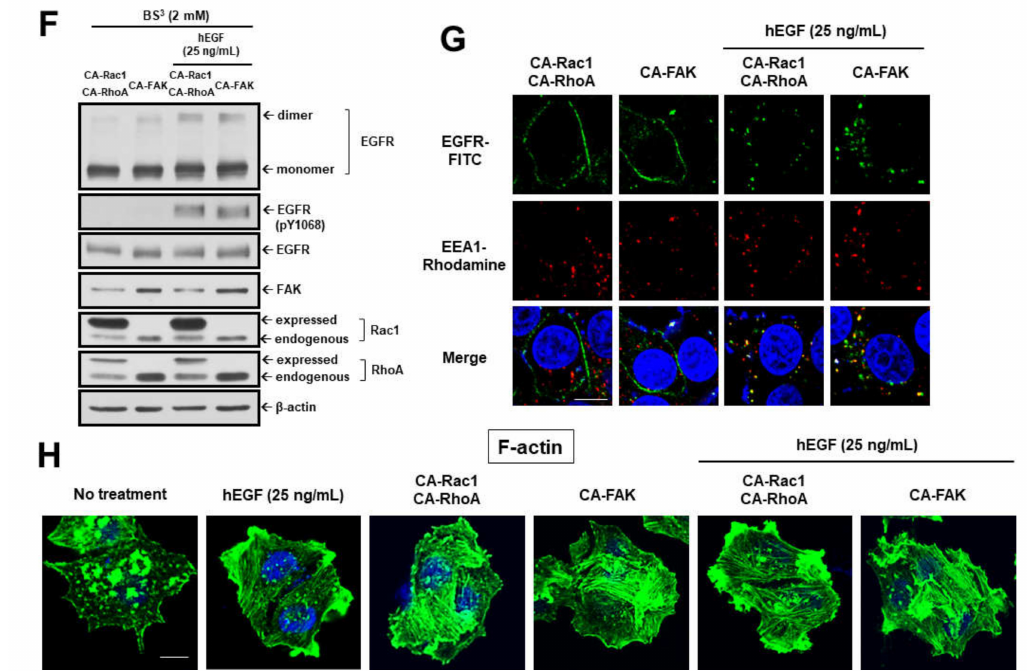
Figure 3. Modulation of actin polymerization by Rac1 / RhoA GTPases is essential for EGF-induced dimerization and endocytosis of EGFR. ( A , E ) The changes in the activation of Rac1 / RhoA-mediated signaling were observed in MCF-7 cells. The interactions between the pairs of molecules indicated were assessed by in situ PLA. *** p < 0.001. ( B , F ) To determine EGFR dimerization, MDA-MB-231 cells were subjected to BS 3 chemical-mediated crosslinking, as described above and in the Materials and Methods. Cell extracts were assessed via Western blotting to determine the dimerization and phosphorylation levels of EGFR and the expression levels of indicated proteins. β -actin was used as a loading control. EGFR endocytosis ( C , G ) and actin cytoskeleton organization ( D , H ) in MCF-7 cells transfected with siRNAs specific for ARP2 and Ezrin or plasmids encoding CA-GTPases or CA-FAK. Original magnification of representative images, 600 × . Scale bars = 10 µ